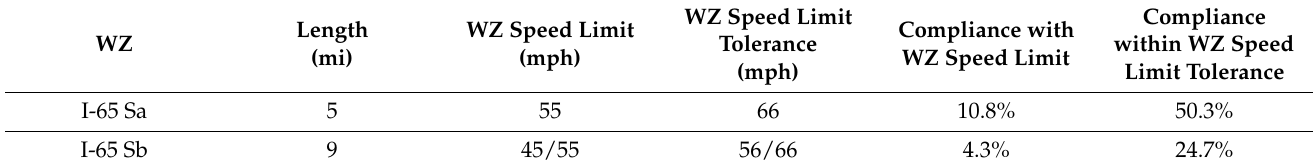
Table 3. Summary of average speed compliance on IN work zones without automated enforcement.